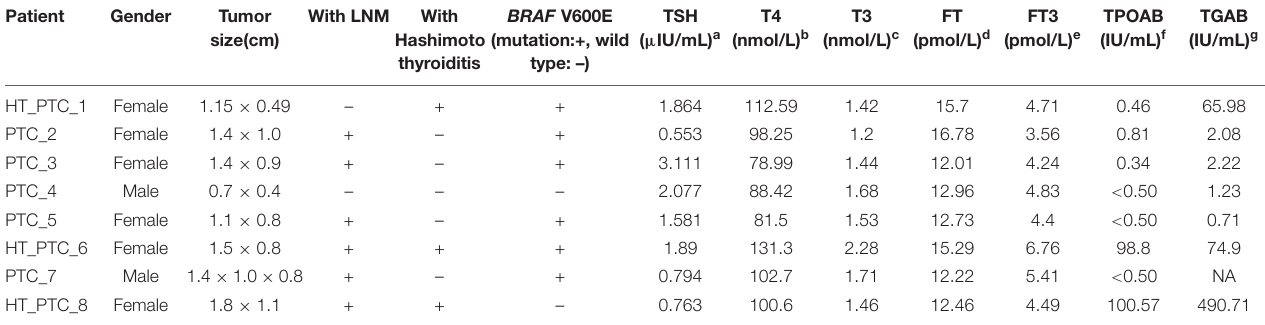
TABLE 1 | Clinical characteristics of